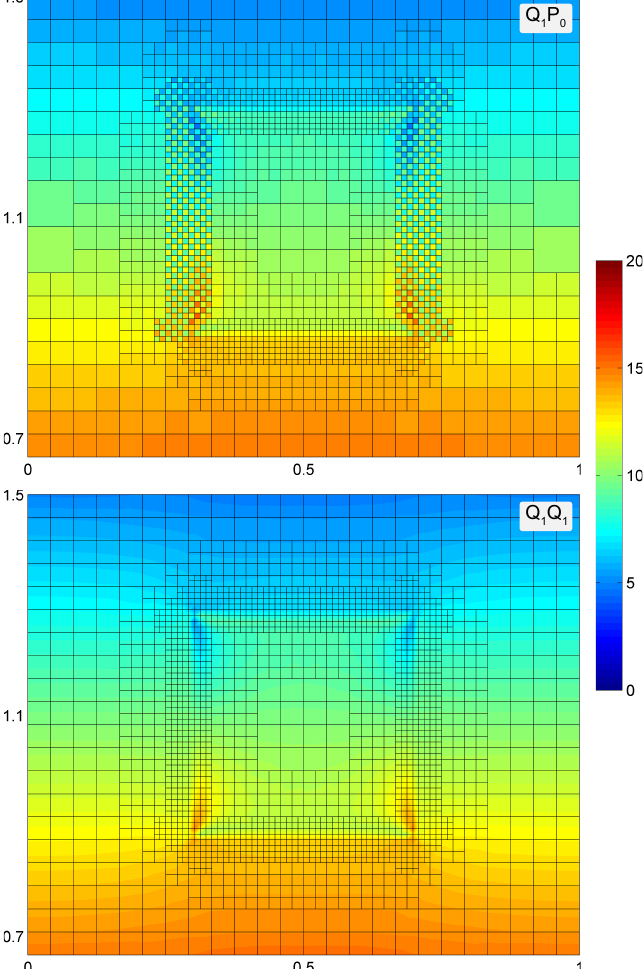
Figure 16. Pressure field around the block obtained with Q 1 Q 1 and Q 1 P 0